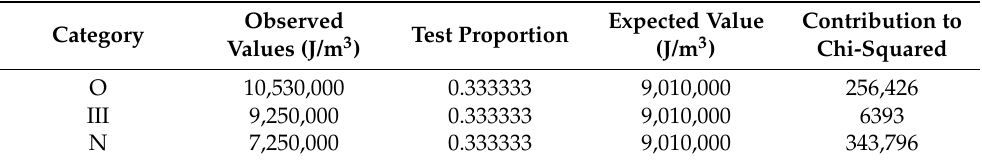
Table 5. Observed and expected mean values of specific energy absorption by sample categories.